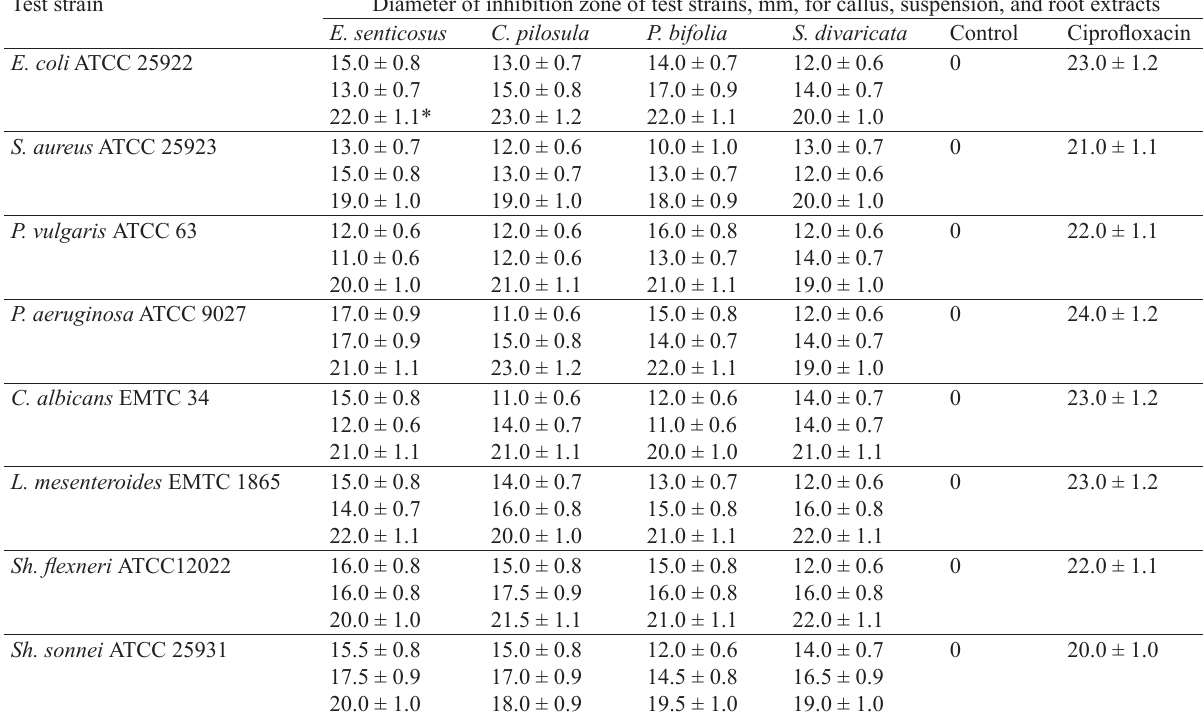
Table 5 Antimicrobial activity of callus, suspension, and root extracts of Eleutherococcus senticosus , Codonopsis pilosula , Platanthera bifolia , and Saposhnikovia divaricate (diffusion method) Test strain Diameter of inhibition zone of test strains, mm, for callus, suspension, and root extracts